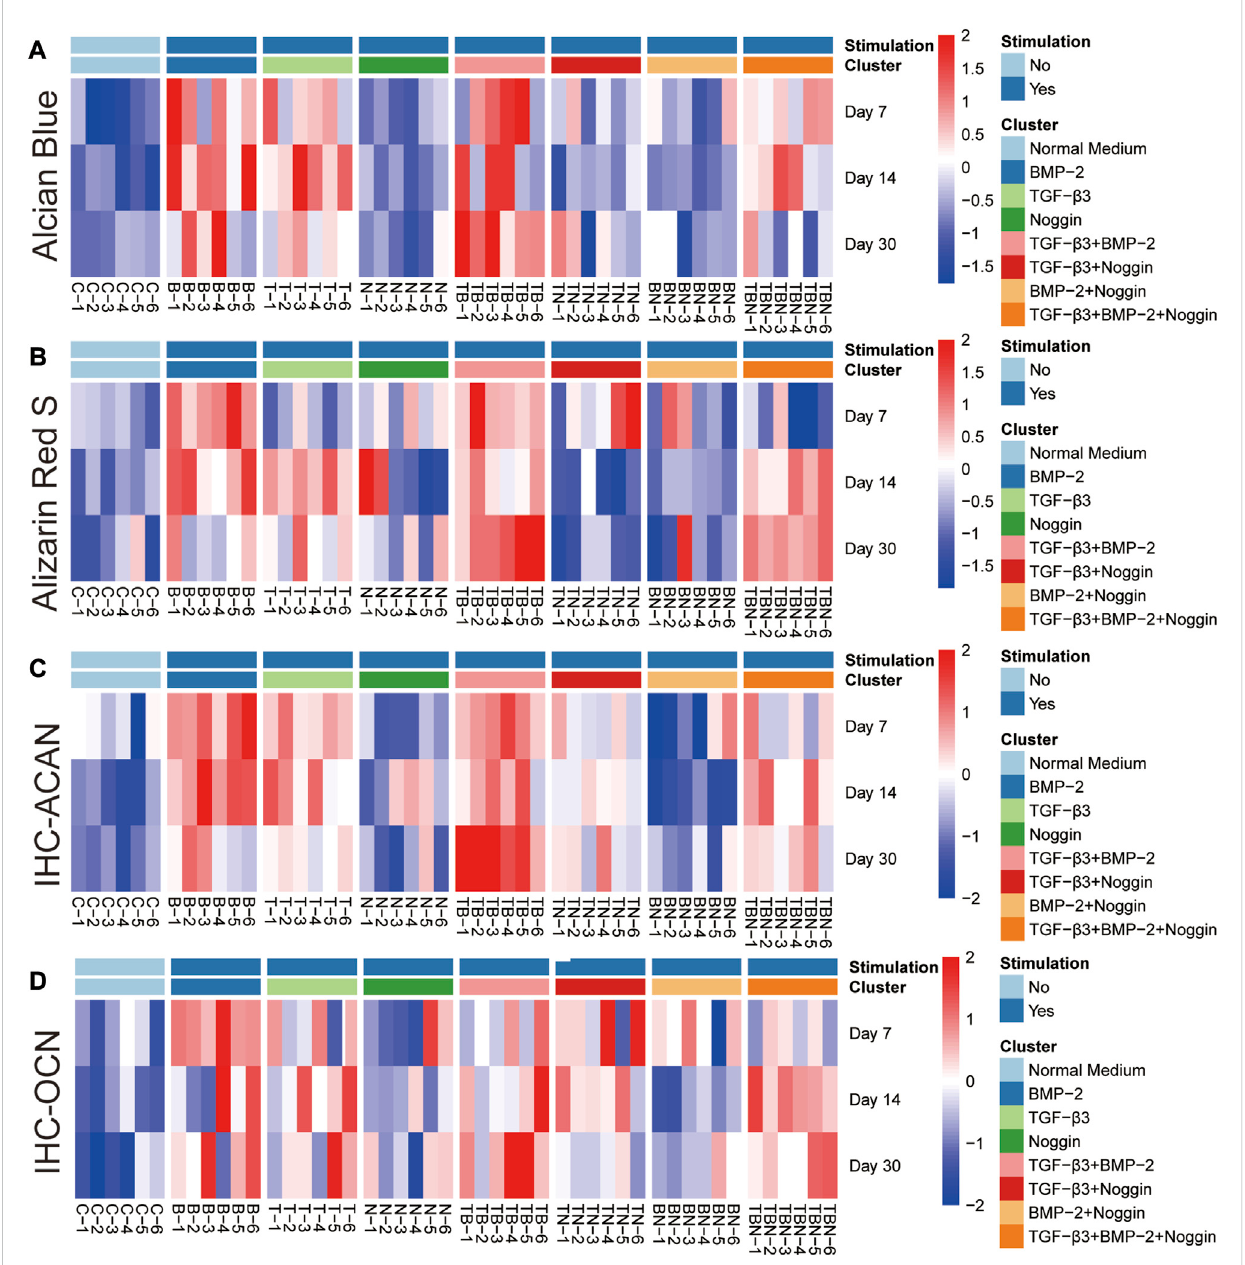
FIGURE 8 Heat map of histomorphometrical analyses. (A) Alcian Blue staining. (B) Alizarin Red S staining. (C) IHC-ACAN staining. (D) IHC-OCN staining. IHC = Immunohistochemistry, ACAN = Aggrecan, OCN = Osteocalcin; (n = 6).